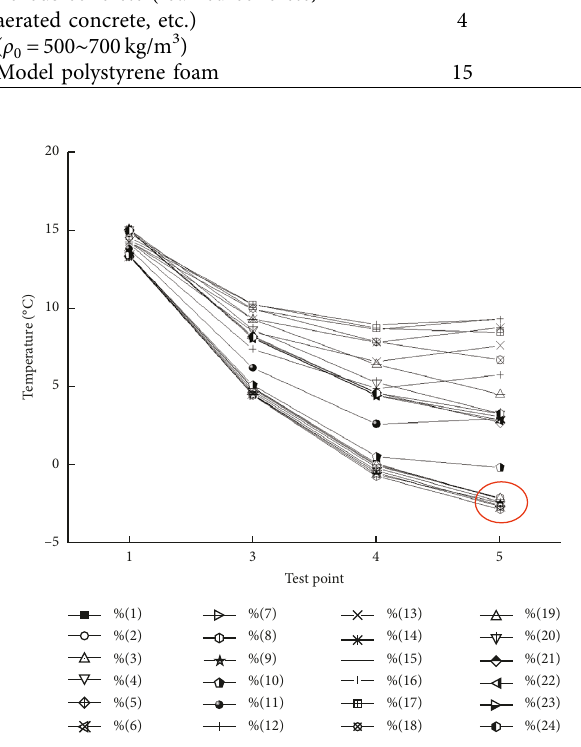
Figure 6: Temperature curve on the hour of the indoor side of the north-facing wall on January 13 (the coldest day during the test period).